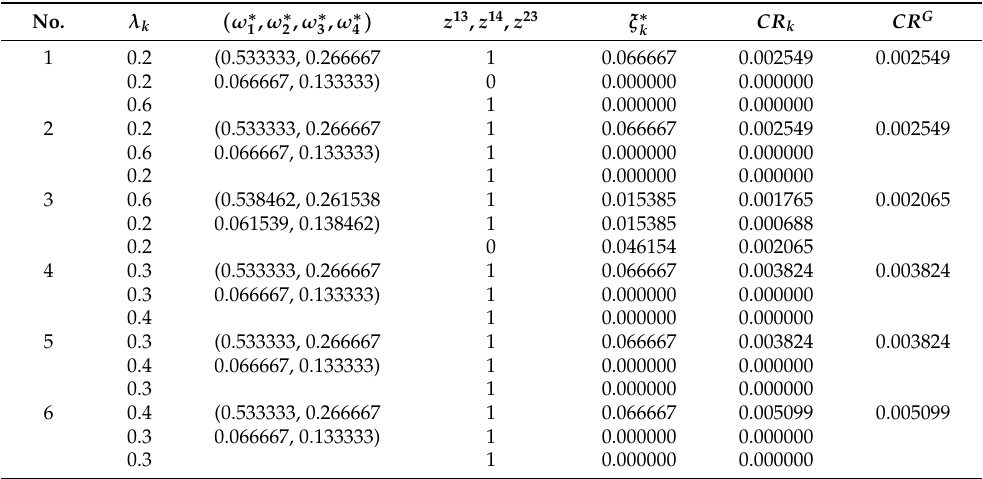
Table 8. Result of Example 2 for